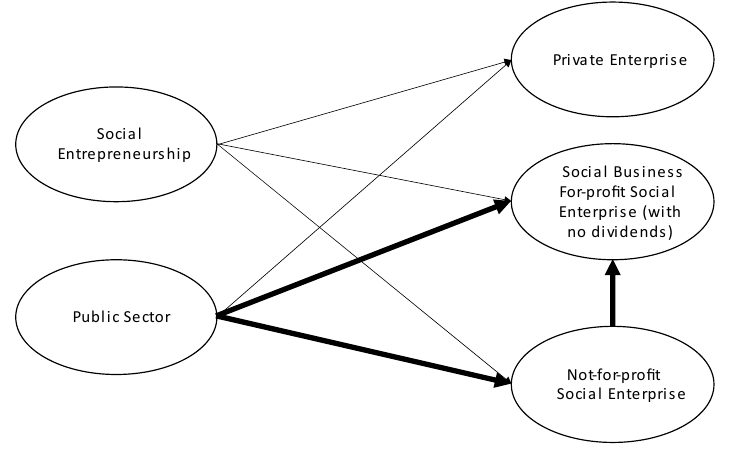
Figure 1. Distinguishing our focus from other cases.